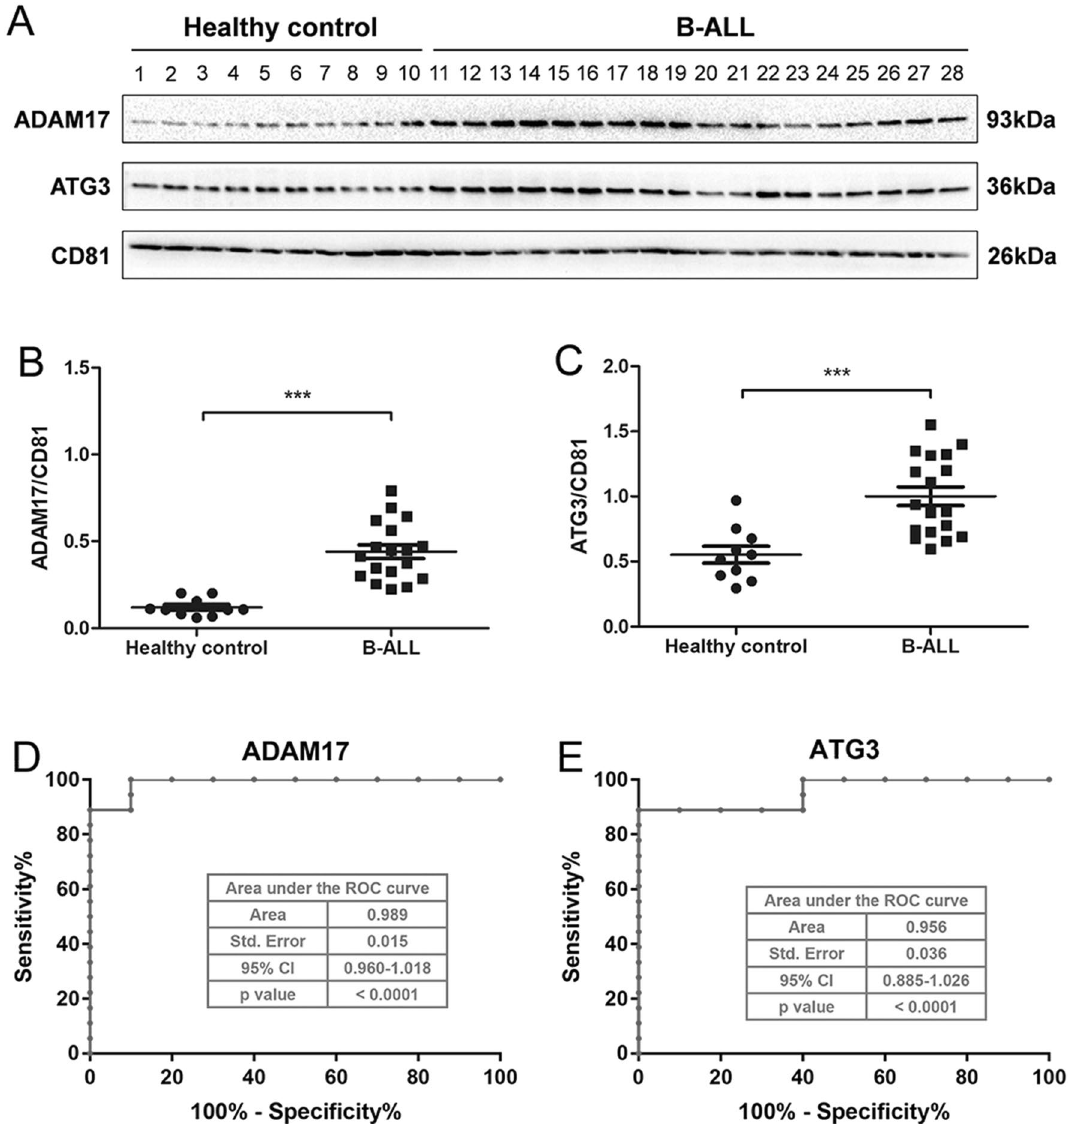
Figure 6. Verification of the predicted candidate proteins. ( A ) Western blot and densitometric analysis of the respective protein band of ( B ) ADAM17 and ( C ) ATG3. The blots were cut prior to hybridization with antibodies. Receiver operating characteristic curves of ( D ) ADAM17 and ( E )